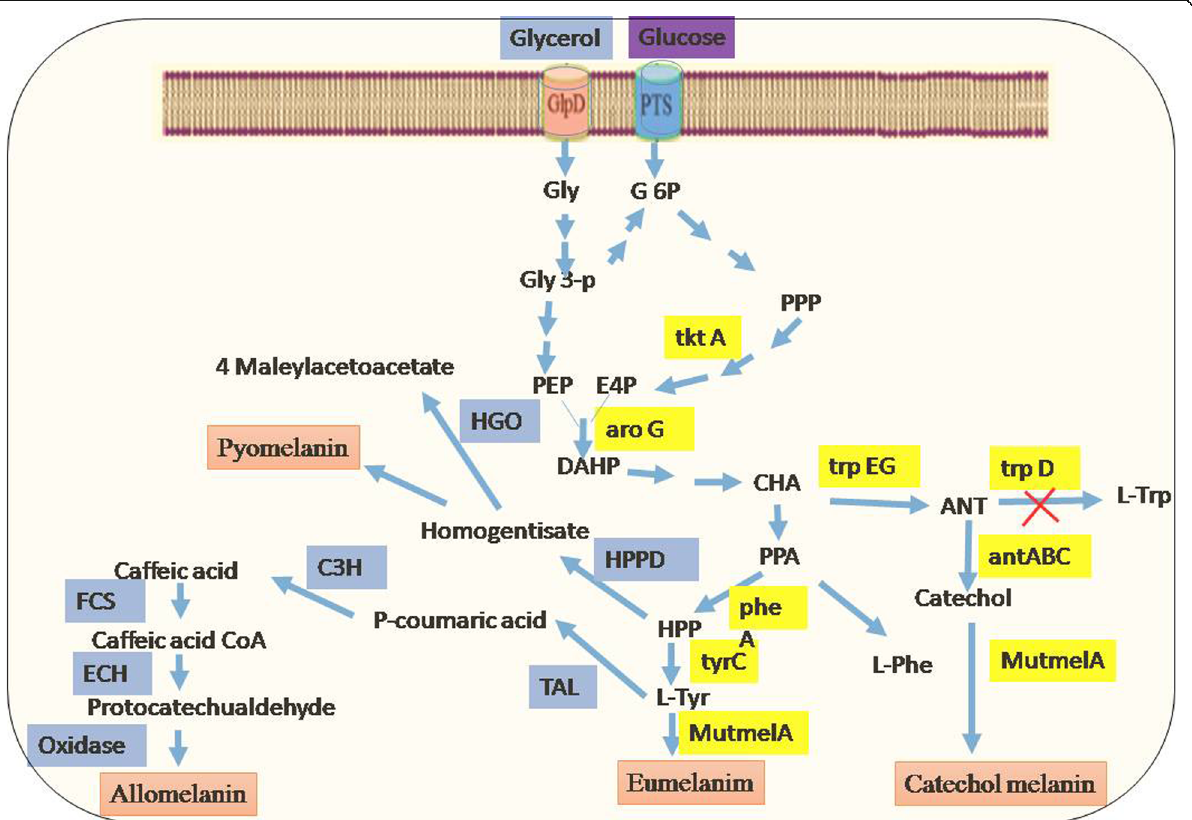
Fig. 6 Biosynthesis pathway of melanin in microbes